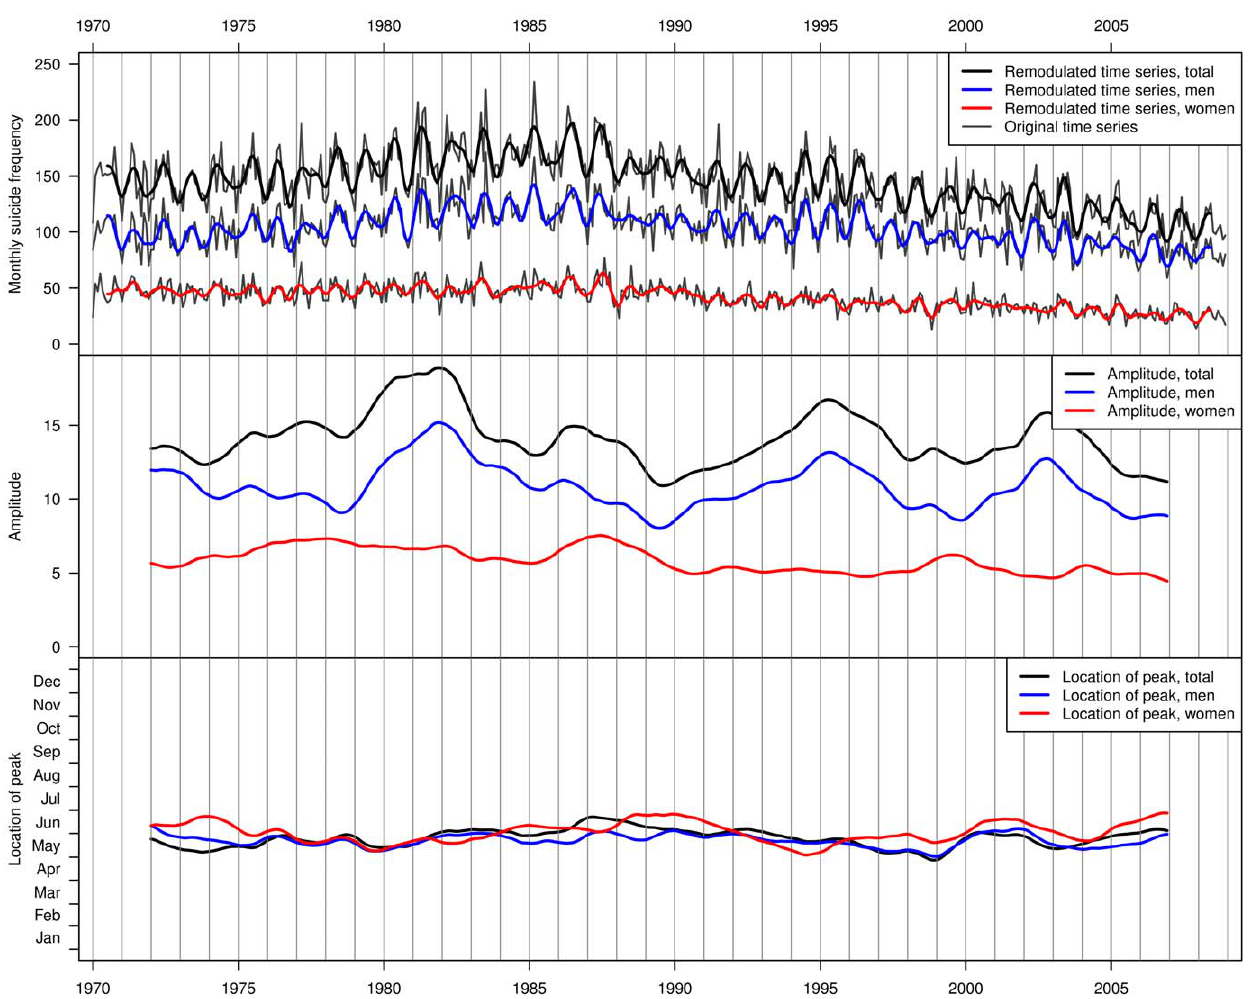
Figure 1. Monthly suicide numbers and complex demodulation results. Upper panel shows the remodulated and original time series of absolute suicide frequencies for the total sample, men, and women. Middle panel depicts the amplitude as a function of time; amplitude is the difference of monthly suicide numbers from the deseasonalized yearly trend at a specific point in time. Lower panel shows the location of the peak (phase) as a function of time. For clarity of presentation, amplitude and phase plots are additionally smoothed by a 37-month centered moving average.